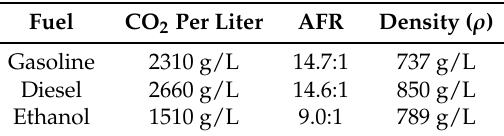
Table 3. Fuel conversion